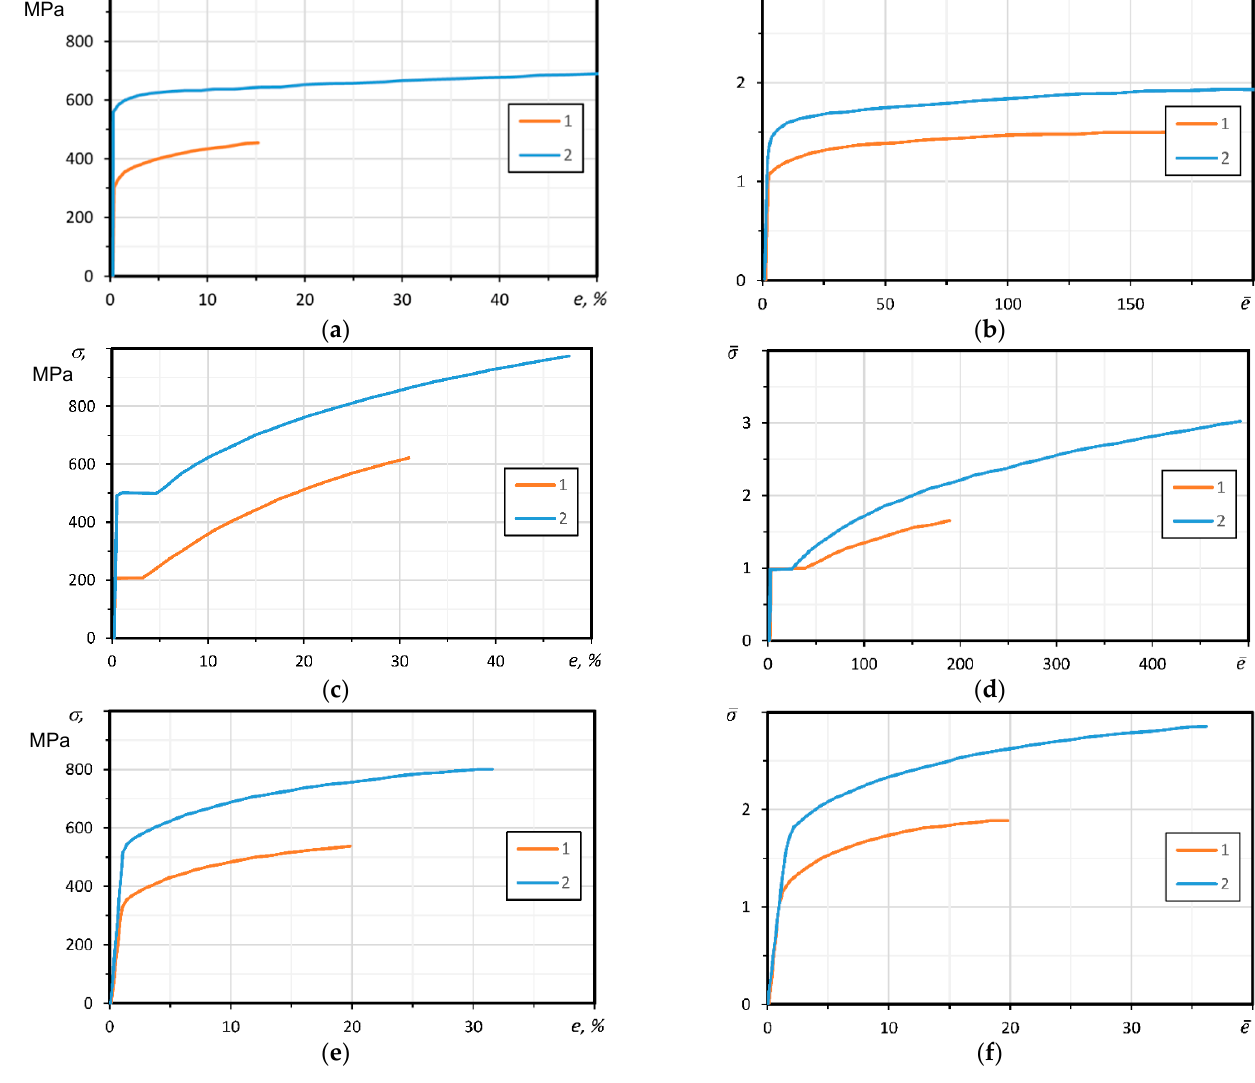
Figure 8. Strain diagrams. For steel 15Cr2MoVa: ( a ) on the absolute coordinates σ – e ; ( b ) on the relative coordinates 𝜎(cid:3364)–𝑒̅ (1 − P = 0.3125%; 2 − P = 99.6875%); steel C45: ( c ) on the absolute coordinates σ – e ; ( d ) on the relative coordinates 𝜎(cid:3364)– 𝑒̅ (1 − P = 0.23%; 2 − P = 99.77%); for aluminium alloy D16TA: ( e ) on the absolute coordinates σ – e ; ( f ) on the relative coordinates 𝜎(cid:3364)– 𝑒̅ (1 − P = 0.42%; 2 − P = 99.58%).